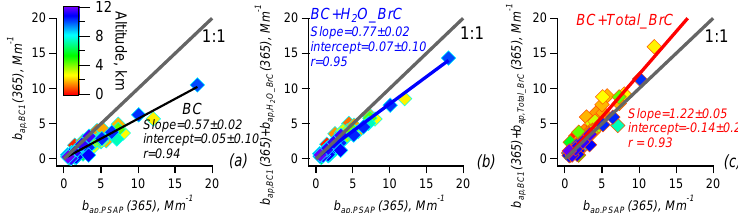
Figure 9. Closure analysis of b ap at 365nm for biomass-burning plumes via scatter plots of estimated (a) BC absorption, (b) sum of BC absorption and water-soluble BrC absorption, and (c) sum of BC absorption and total BrC absorption compared with total aerosol absorption based on PSAP data. Markers were color-coded by altitude. Orthogonal distance regression (ODR) fit results are shown. The 1 : 1 line is also included. (Measurement uncertainties of the various absorption coefficients are estimated to be between ± 28 and ±